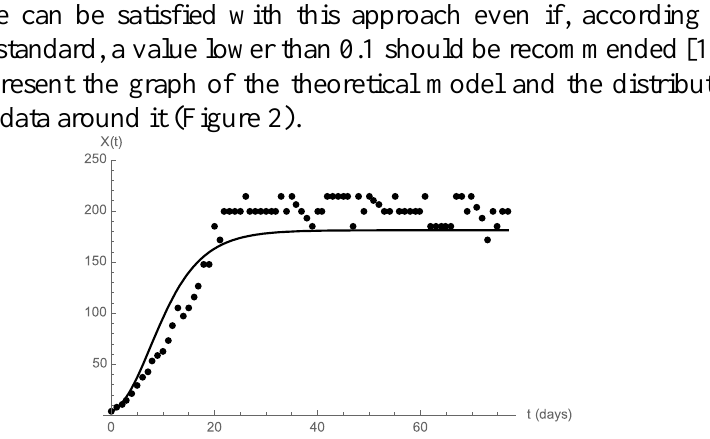
Figure 2. On the t-axis there is time in days, on the ordinates there is the volume of